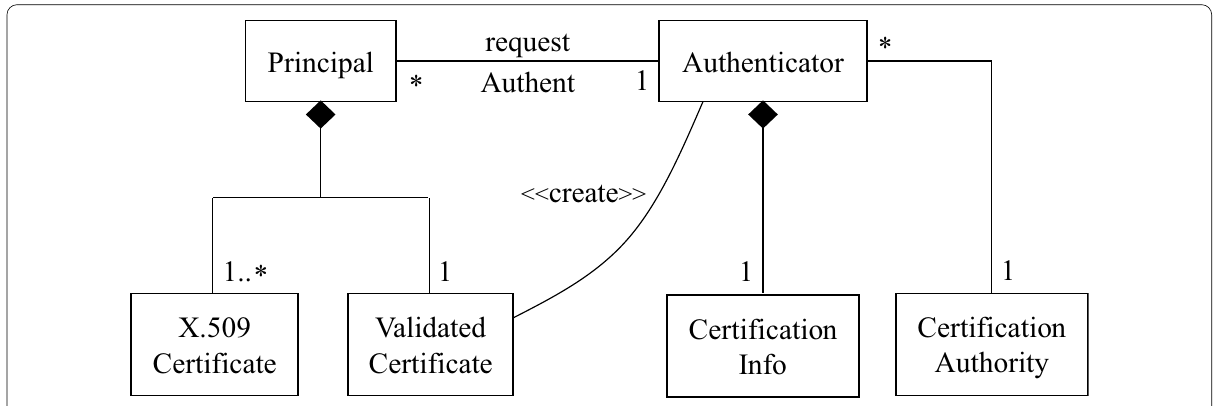
Fig. 5 Class model of the X.509-based authenticator